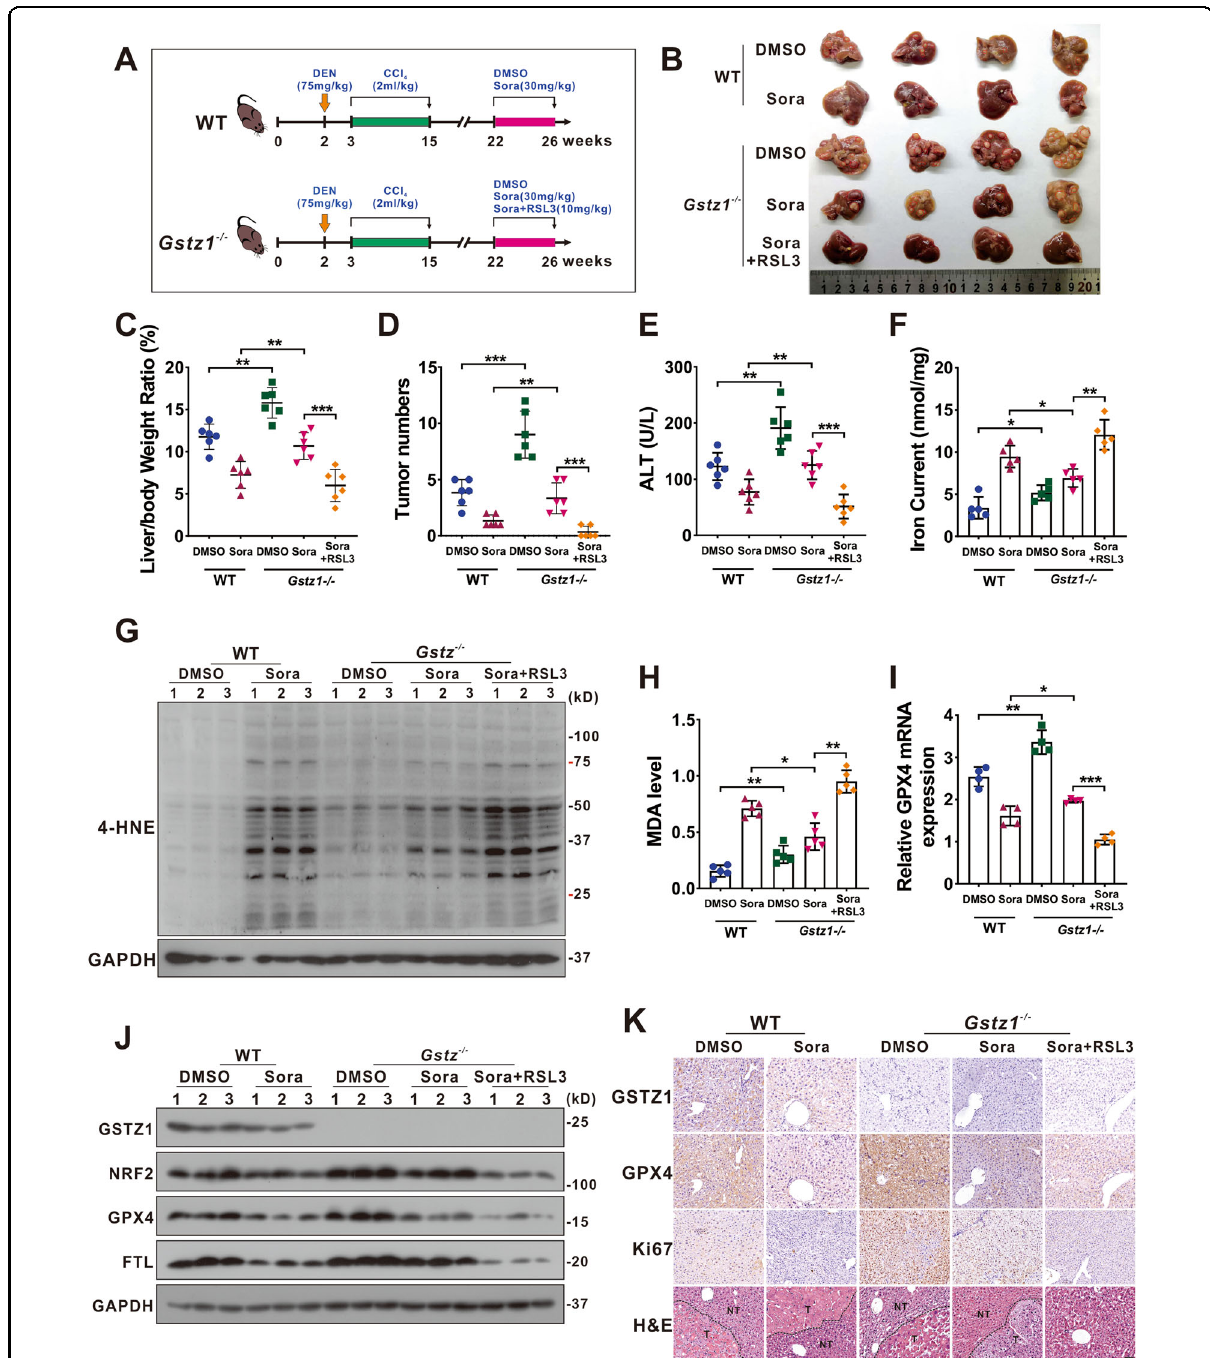
Fig. 7 RSL3 enhances the anticancer activity of sorafenib in Gstz1 − / − mice. A Schematic representation of the experimental design for mice. B Gross appearances of liver tumors. The red circles represent tumors. C – E In vivo analyses of liver/body weight ratio ( C ), tumor numbers ( D ), and serum alanine aminotransferase (ALT) ( E ) levels of the fi ve groups. ( n = 6). F – H Levels of iron ( F ) ( n = 5), 4-HNE modi fi cation ( G ) ( n = 3) and MDA ( H ) ( n = 5) in mice were assayed. I , J mRNA ( I ) ( n = 4) and protein ( J ) ( n = 3) levels of GPX4, FTL, and SLC7A11 in the liver tumors as assessed using qRT- PCR and western blotting, respectively. K Representative H&E staining and immunohistochemistry images of GSTZ1, GPX4, and Ki67 in hepatic tumors. Scale bar = 50 μ m. For western blotting, 50 μ g protein was loaded per well. WT wild-type, DEN diethylnitrosamine, CCl 4 carbon tetrachloride, DMSO dimethyl sulfoxide, Sora sorafenib, RSL3 Ras-selective lethal small molecule 3, ALT alanine aminotransferase, 4-HNE 4-hydroxy-2-nonenal, H&E hematoxylin and eosin. * p < 0.05, ** p < 0.01, *** p < 0.001, Student ’ s t -test (two groups) or one-way ANOVA followed by Tukey ’ s tests ( fi ve